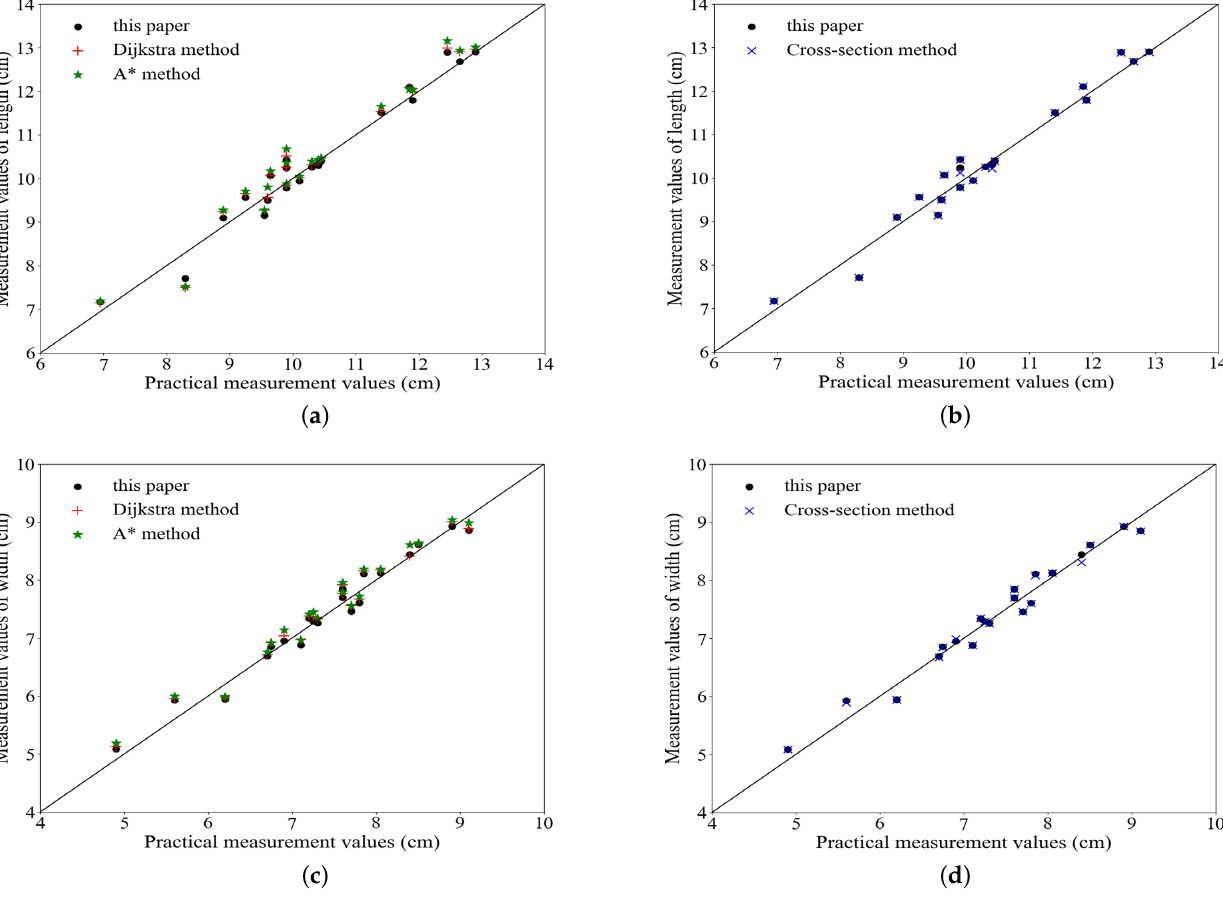
Figure 7. Comparison of the length and width values measured by algorithms with actual values. ( a ) Comparison of the geodesic distance method with this paper on leaf length. ( b ) Comparison of cross-section method with this paper on leaf length. ( c ) Comparison of geodesic distance method with this paper on leaf width. ( d ) Comparison of cross-section method with this paper on leaf